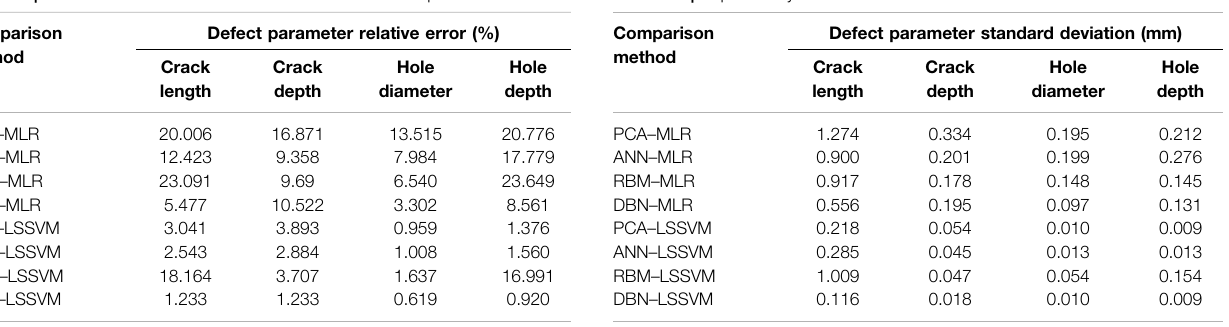
TABLE 6 | Repeatability of the evaluation